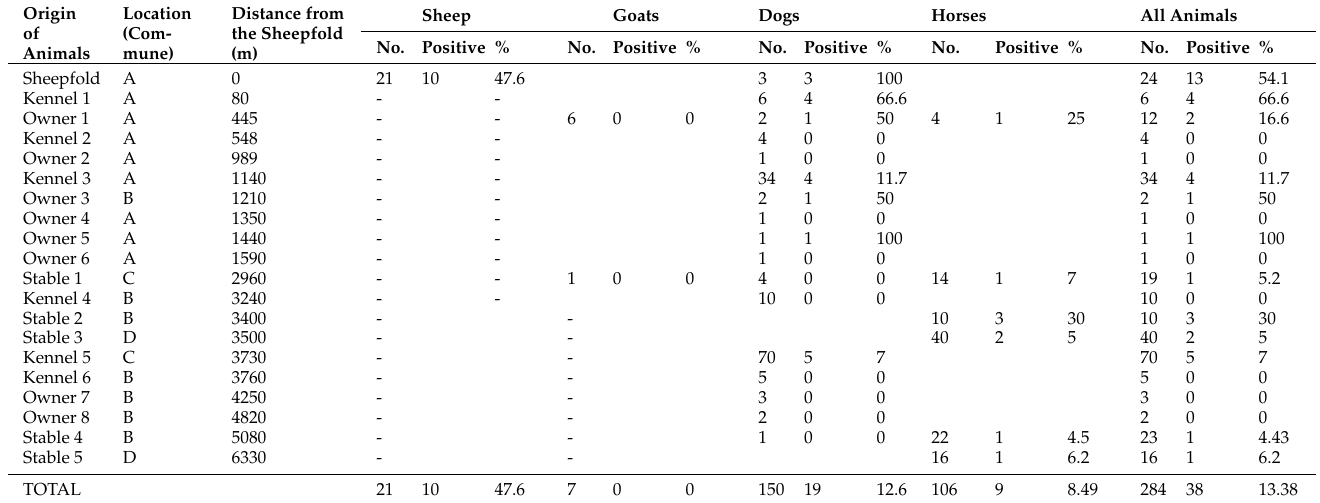
Table 2. Distribution of Q fever seroprevalence according to animal species and their distance from the